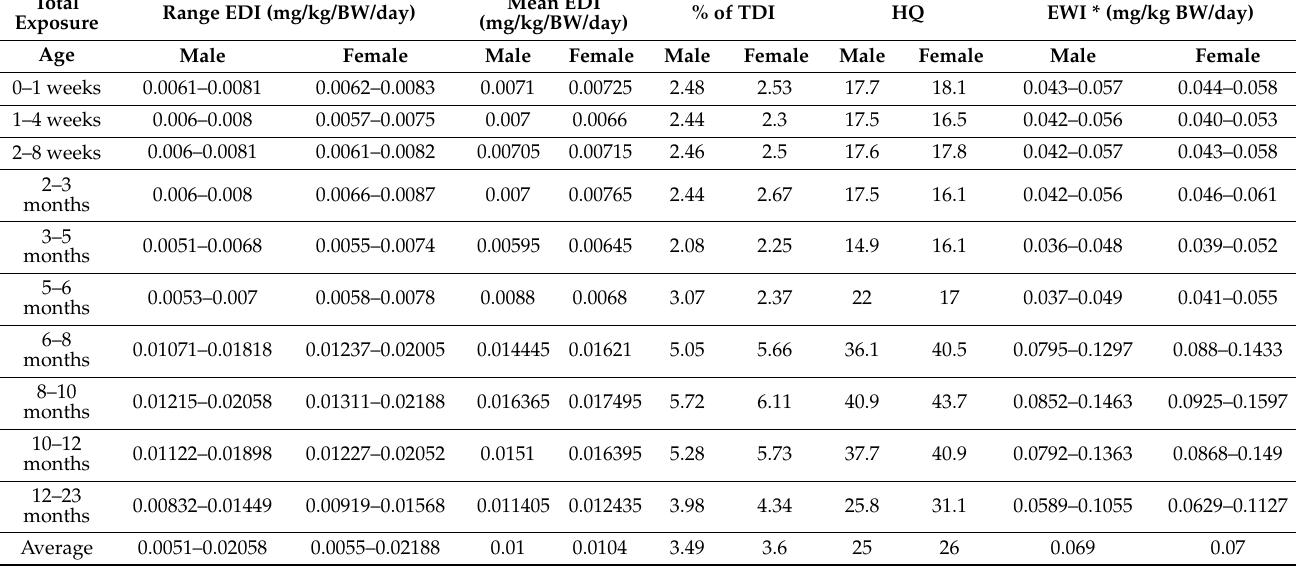
Table 5. Total exposure and pediatric health risk assessment to aluminum among male and female infants aged under five years through infant formula and complementary food consumption at different ages, calculated through EDI, the % of TDI, HQ, and